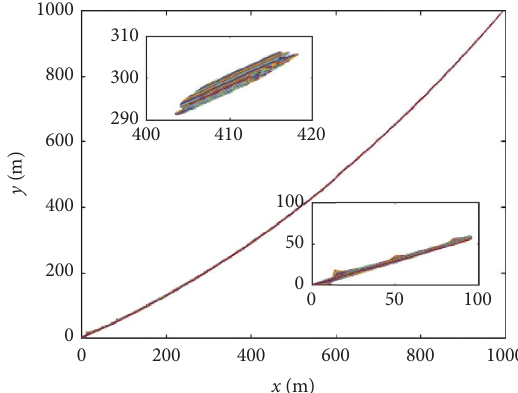
Figure 4: Amplitude distribution of tangential motion of mooring line.